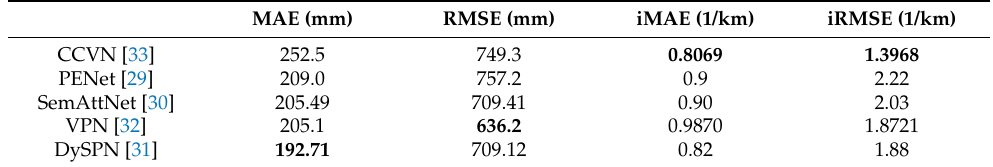
Table 2. Comparison of the methods that have been tested on the KITTI depth completion dataset showing the mean absolute error (MAE) and root mean squared error (RMSE), both in millimetres, and also the inverse mean absolute error (iMAE) and inverse root mean squared error (iRMSE), both in one/kilometres. The results with the highest accuracy are shown in bold.